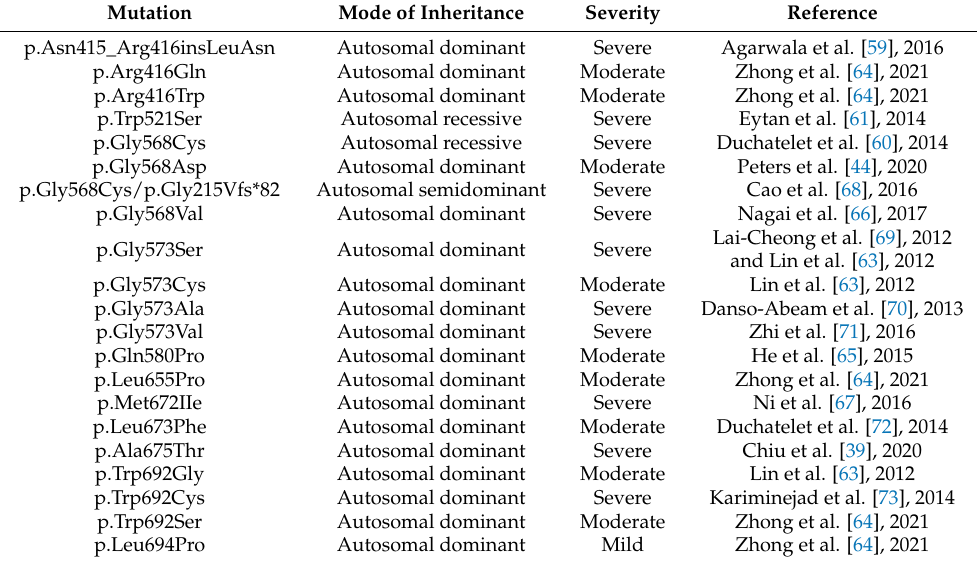
Table 2. TRPV3 mutations that cause Olmsted